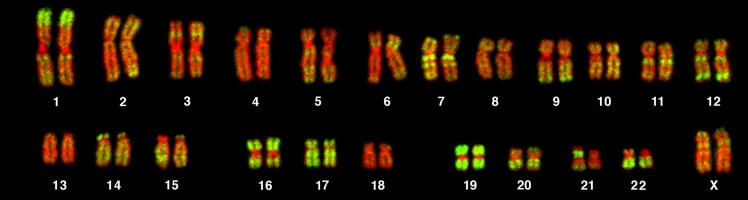
In this karotype from a female human lymphocyte, the gene-rich areas are stained green and the gene-poor areas are red (Photo: Irina Solovei)